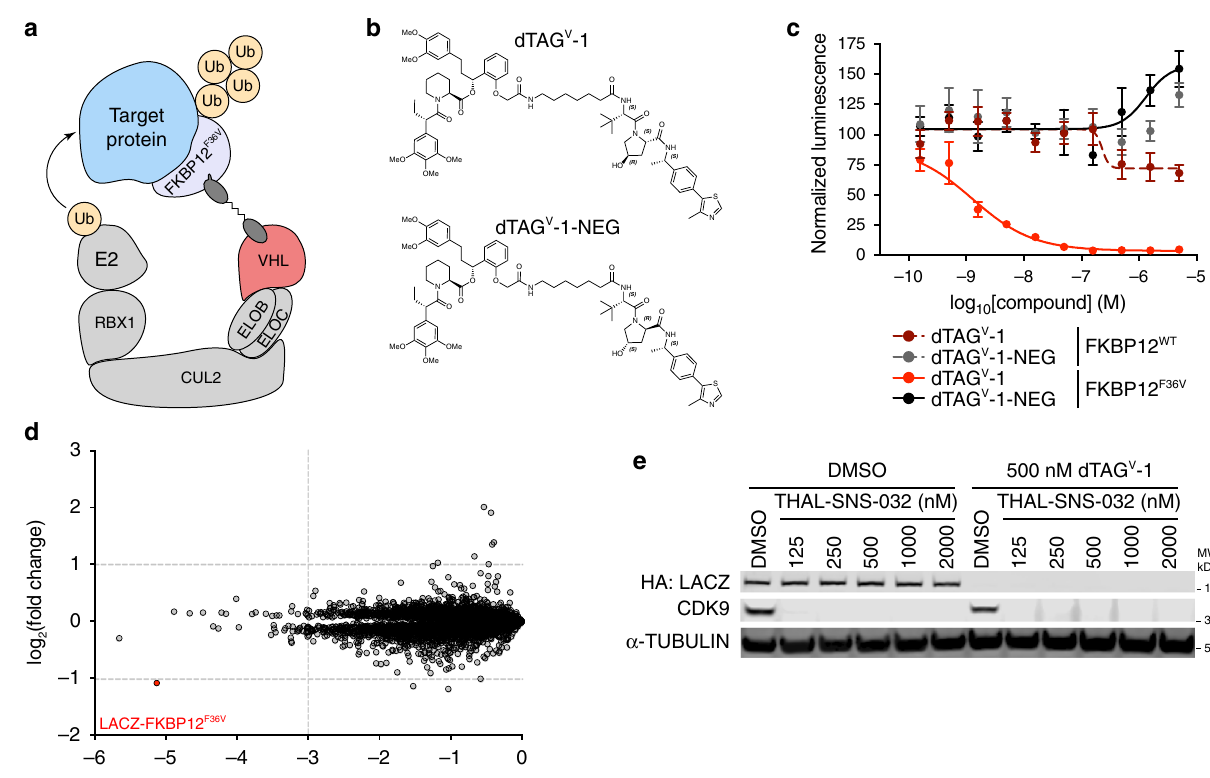
Fig. 1 dTAG V -1 is an exclusively selective degrader of FKBP12 F36V -tagged proteins. a Schematic depiction of the dTAG system using VHL-recruiting dTAG molecules. VHL-recruiting dTAG molecules promote ternary complex formation between the FKBP12 F36V -tagged target protein and E3 ubiquitin ligase complex, inducing target protein ubiquitination and degradation. b Chemical structures of dTAG V -1 and dTAG V -1-NEG. c DMSO-normalized ratio of Nluc/Fluc signal of 293FT FKBP12 WT -Nluc or FKBP12 F36V -Nluc cells treated with dTAG V -1 or dTAG V -1-NEG for 24 h. Data are presented as mean ± s.d. of n = 4 biologically independent samples and are representative of n = 3 independent experiments. d Protein abundance after treatment of PATU-8902 LACZ-FKBP12 F36V clone with 500 nM dTAG V -1 for 4 h compared to DMSO treatment. Volcano plots depict fold change abundance relative to DMSO versus P value derived from a two-tailed Student ’ s t -test. Fold change values and signi fi cance designations derived from a two-tailed Student ’ s t -test and a permutation-based FDR estimation are provided in Supplementary Data 2. Data are from n = 3 biologically independent samples. e Immunoblot analysis of PATU-8902 LACZ-FKBP12 F36V clone co-treated with DMSO, THAL-SNS-032, and/or dTAG V -1 as indicated for 24 h. Data is representative of n = 3 independent experiments. Source data for c and e are provided as a Source Data fi